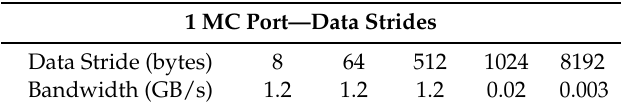
Table 3. Data strides bandwidth (1 MC